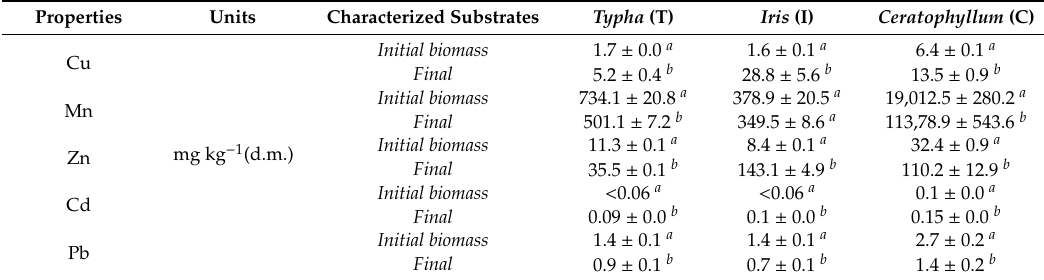
Table 2. Microelement content in plant waste and the obtained